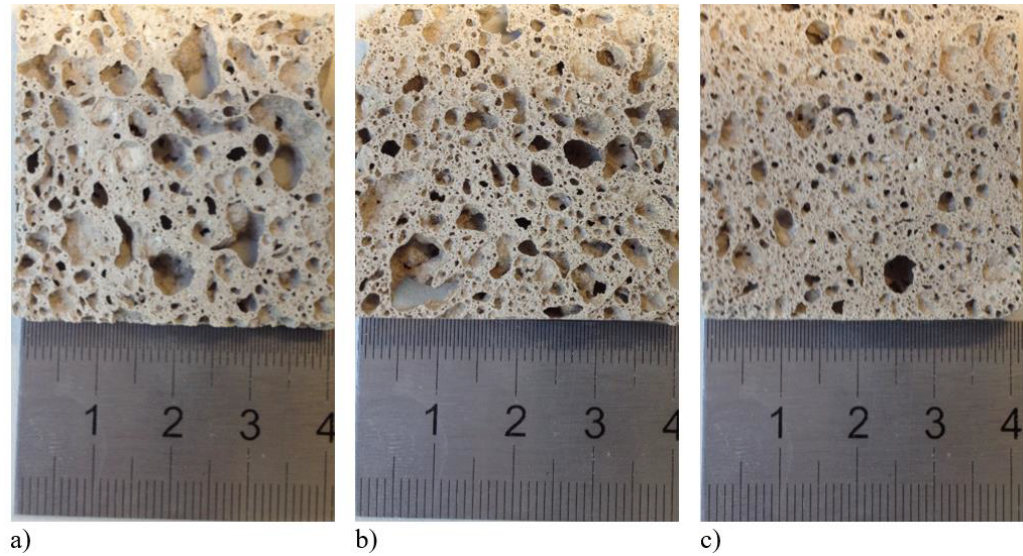
Figure 8: Pores size of geopolymer foams with various content of reinforcing fibre a) 10%, b) 30%, c) 50 % (total image width: 40